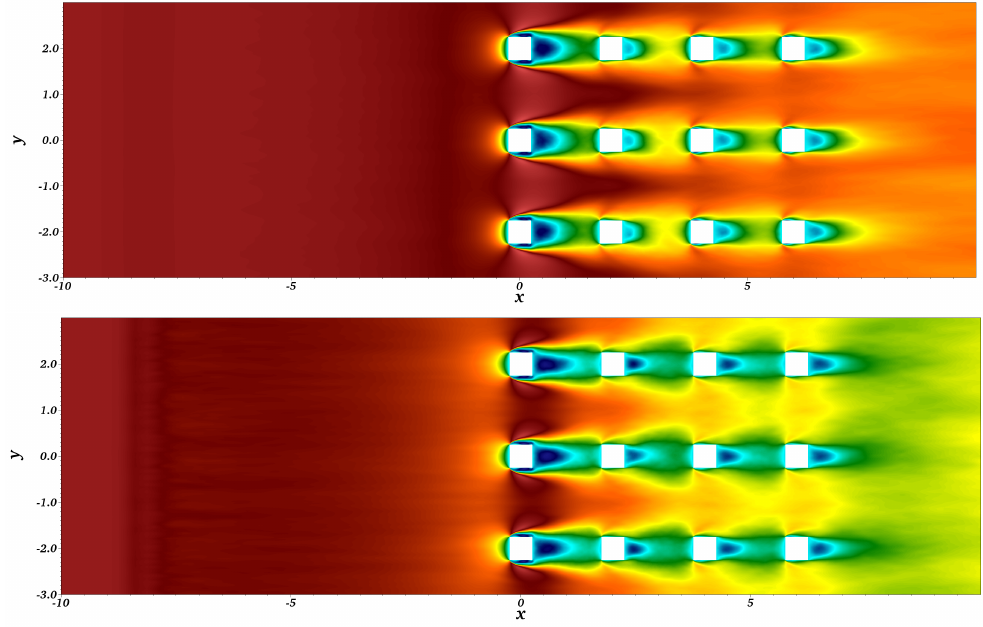
Figure 4. Mean streamwise velocity U on the ( top ) z = 0.85 and ( bottom ) z = 0.25 planes, where colors range from (dark blue) − 0.4 to (dark red) 1.1.